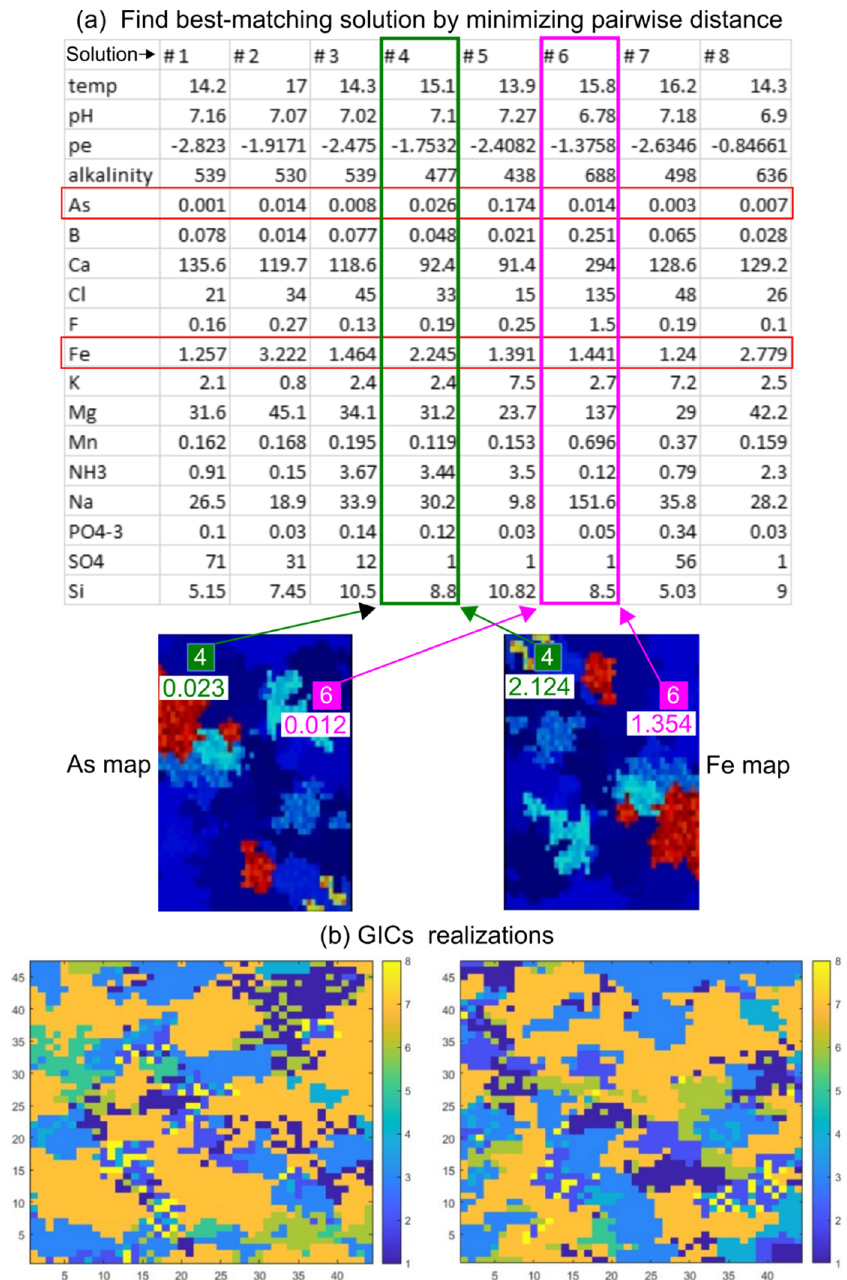
Figure 4. ( a ) The example shows how pairs of As and Fe values are extracted from two specific cells on As ( left ) and Fe ( right ) random maps and associated to the closest PHREEQC solution ( b ) Two maps showing the distribution of PHREEQC solutions after completing the mapping in the whole domain. These maps represent the geochemical initial conditions (GICs) used to populate the stochastic PHAST models.